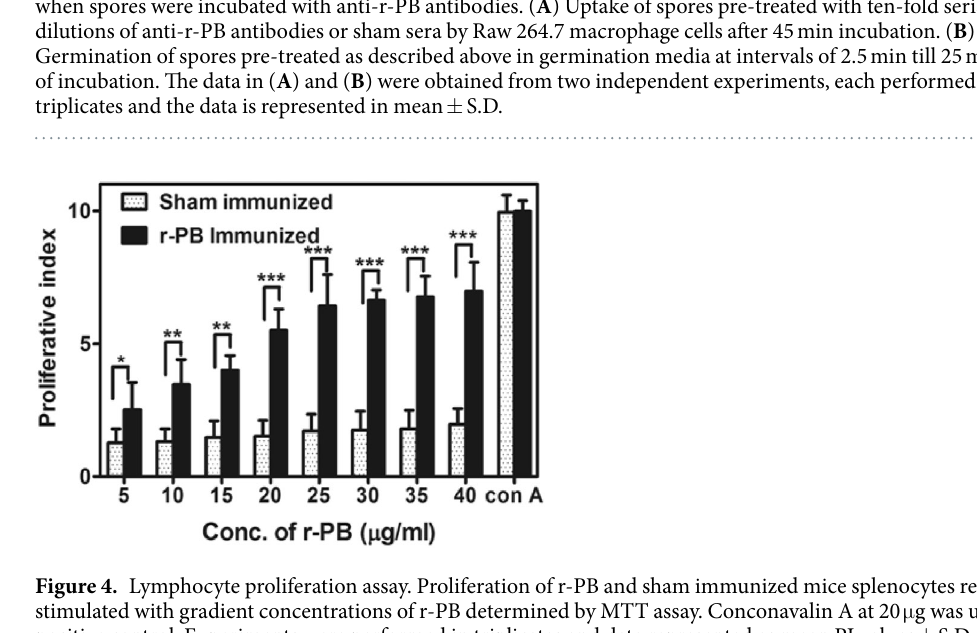
Cytokine Estimation.